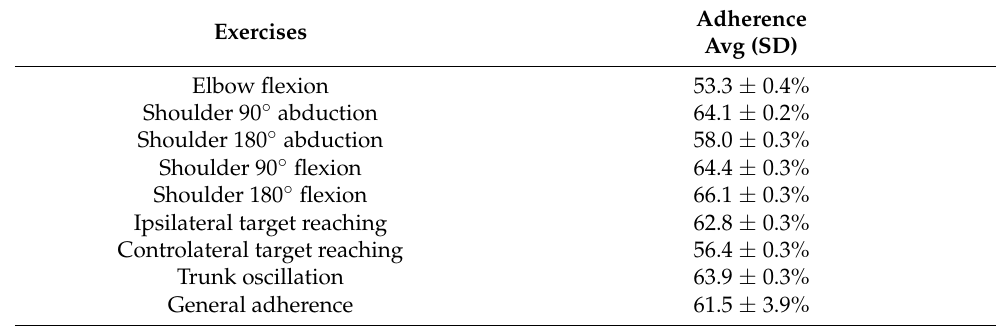
Table 2. Average adherence for each exercise and the whole treatment. The percentage represents the average portion of time spent by participants in the IG in each exercise compared to the time required by the protocol (60 1 h sessions).